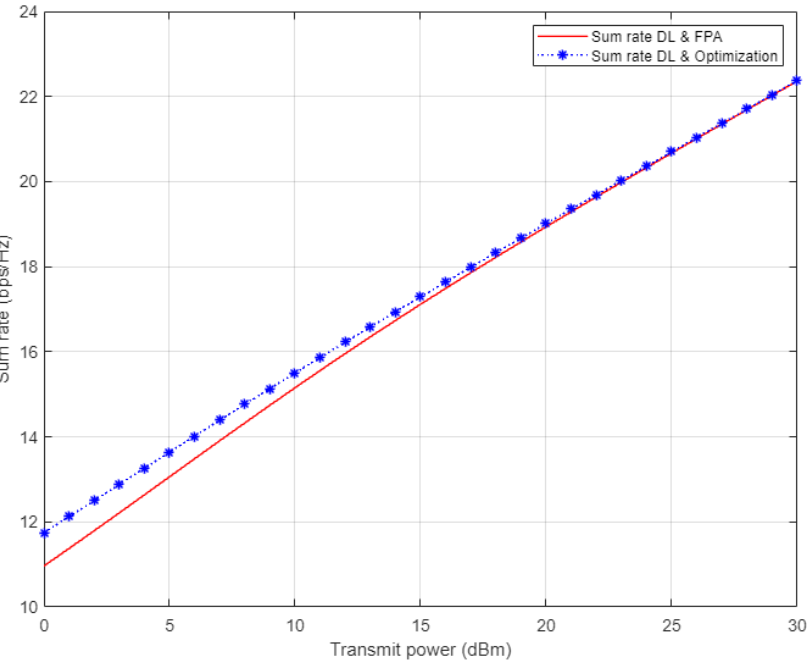
Figure 14. Sum rate vs. power for DL-based optimized and FPA power schemes (Rayleigh Chan- nel).